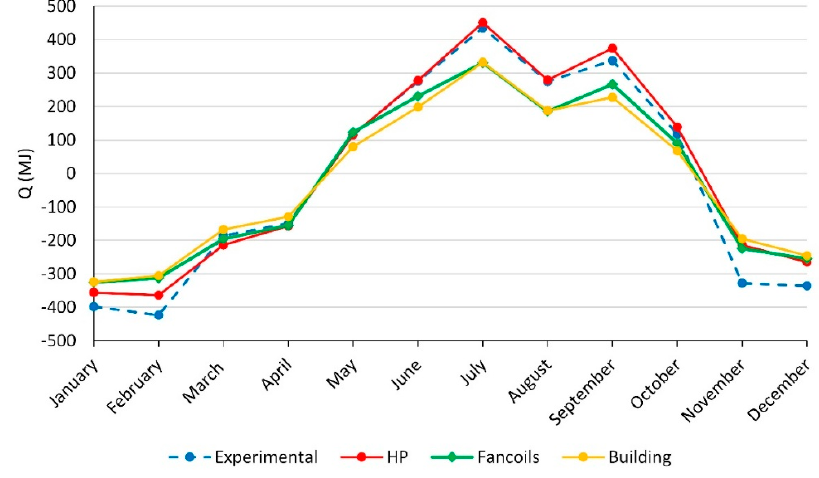
Figure 8. Thermal load simulation results for the first three steps of the model development.